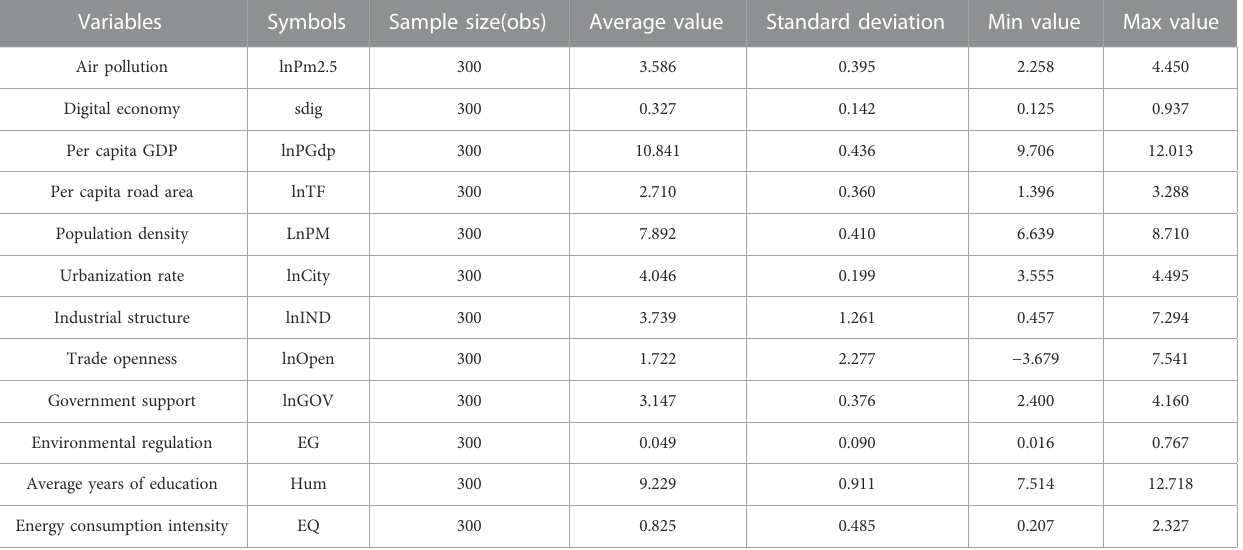
TABLE 1 Descriptive statistical analysis of the main